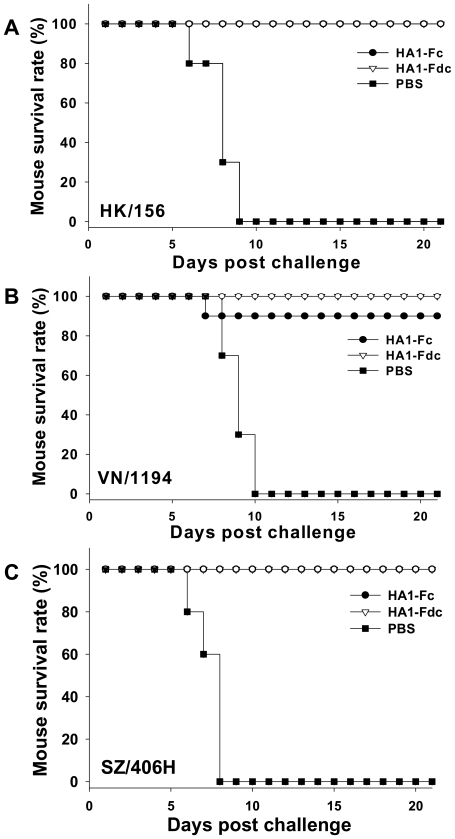
Cross-clade protection of HA1-Fc- or HA1-Fdc-vaccinated mice against lethal H5N1 virus challenge.HA1-Fc- and HA1-Fdc-vaccinated mice were challenged with 10 LD50 of three clades (clade 0: HK/156, clade 1: VN/1194, and clade 2.3.4: SZ/406H) of H5N1 virus. PBS was used as the negative control. Groups of 10 mice were observed for survival for 21 days post-virus challenge, and corresponding survival rates were calculated. Survival rate (%) of mice challenged with HK/156 (A), VN/1194 (B), and SZ/406H (C) H5N1 virus was shown.